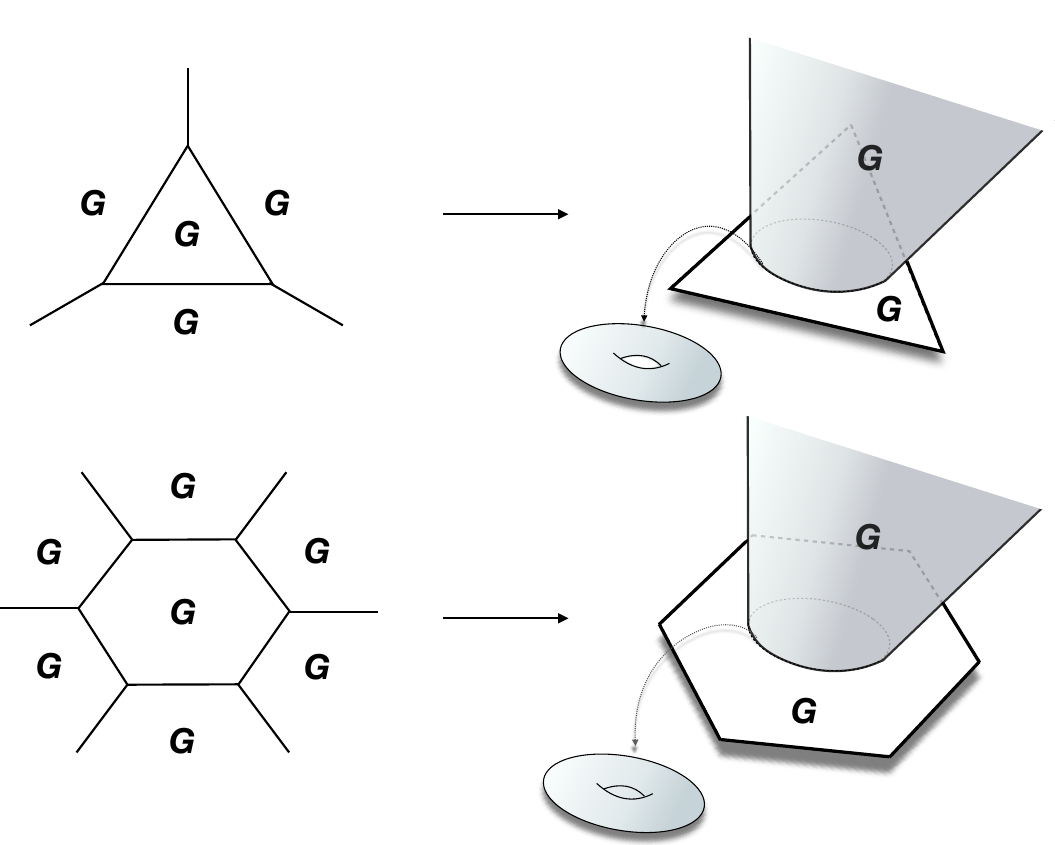
Figure 10 . On the left mutually meeting non-compact surfaces with group G and all meeting at a compact P 2 (toric diagram: triangle) on top, or dP 3 (toric diagram, hexagon) on the bottom with gauge group G on P 1 curves. On the right the smoothing where a recombined non-compact surfaces intersects the dP 3 or P 2 on a T 2